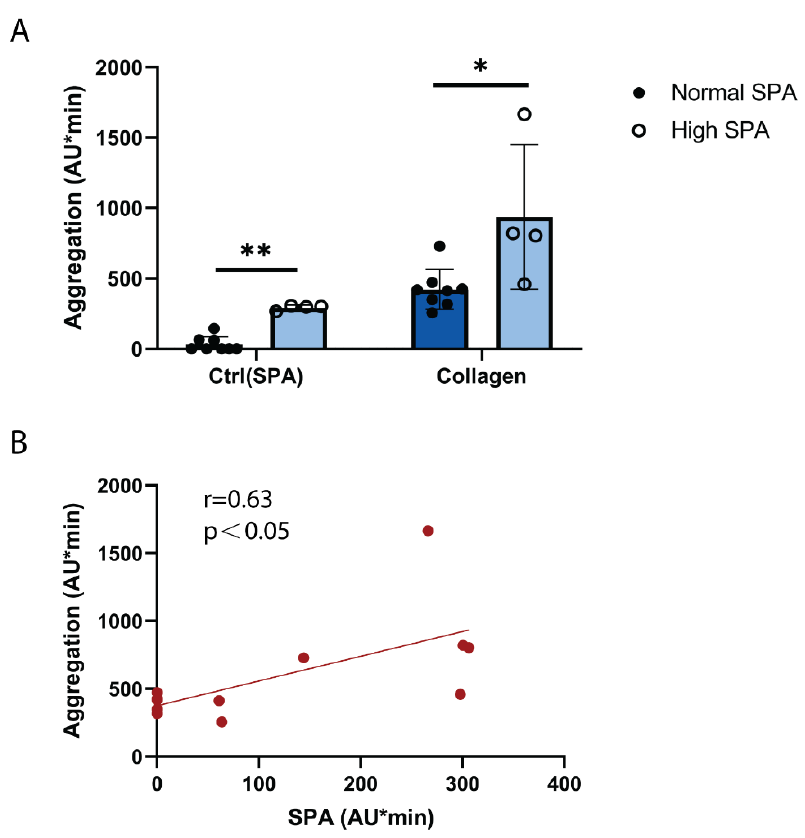
Figure 3. High SPA is associated with increased platelet GPVI reactivity . Hirudin-anticoagulated blood was prewarmed at 37 °C for 3 min. Collagen (0.1 µg/mL) was added, stirring was started, and platelet aggregation was measured for 10 min. ( A ) Blood of donors with high SPA responded more strongly to low-dose collagen than donors with normal SPA. Values are mean ± SD ( n = 4 with high SPA and n = 8 with low SPA). * p < 0.05, ** p < 0.01. ( B ) SPA and platelet reactivity to collagen (0.1 µg/mL) correlate positively and significantly (Spearman correlation coefficient r = 0.63; p = 0.03). Each data point represents an individual subject ( n = 12).